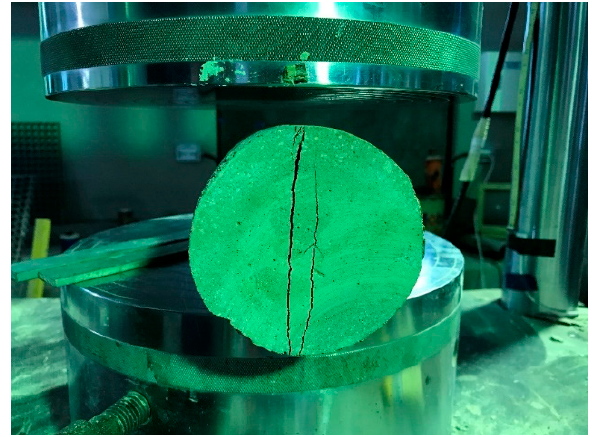
Figure 17. Failure mode of splitting test.